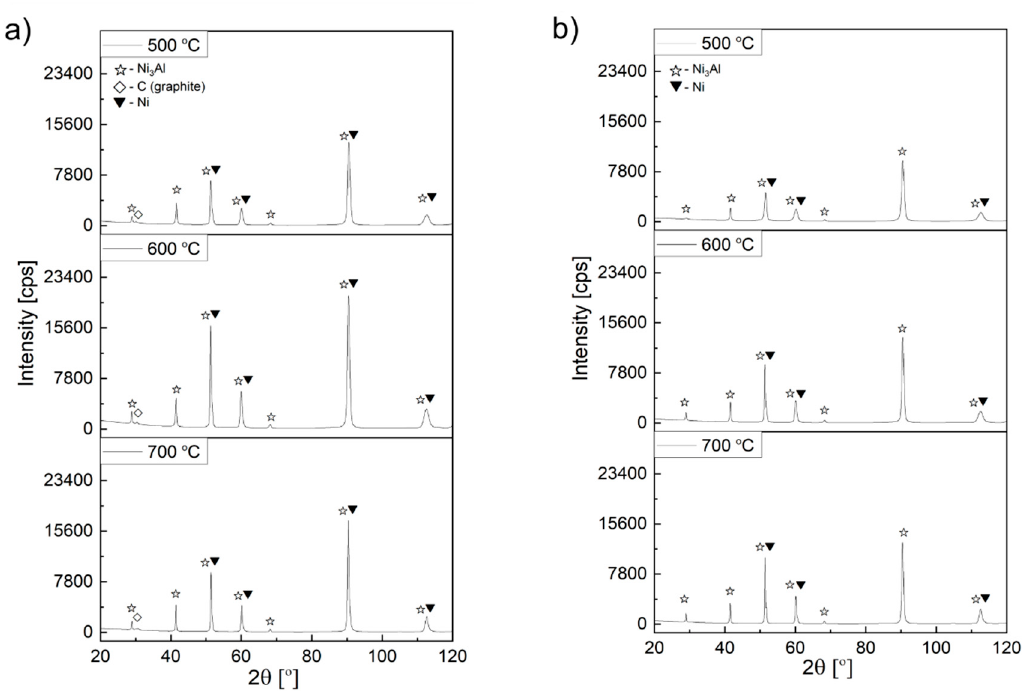
Figure 13. XRD profile obtained from Ni 3 Al foil surface after decomposition of: ( a ) ethanol with water vapour addition 0.17 wt.% (mixture #2) and ( b ) ethanol with 1.1 vol.% water vapour addition (mixture #3).